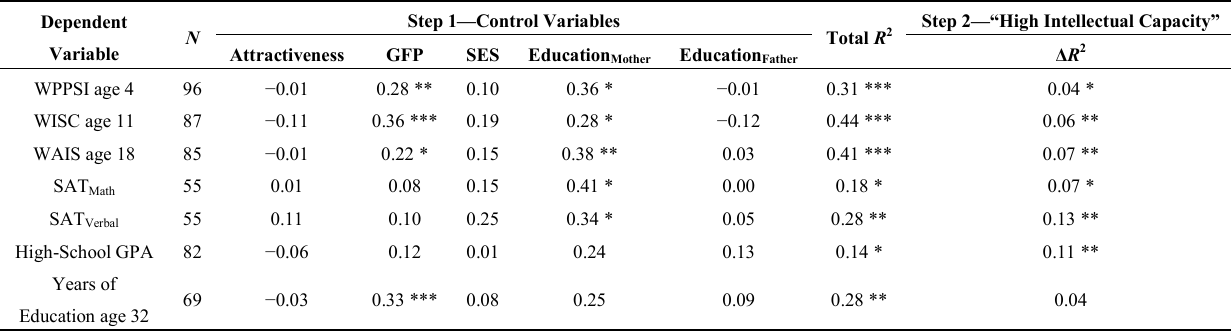
Table 2. Regression analyses predicting intellectual ability and scholastic outcomes from “high intellectual capacity” rating as judged at ages 3–4 (controlling for physical attractiveness, GFP, SES, and parental